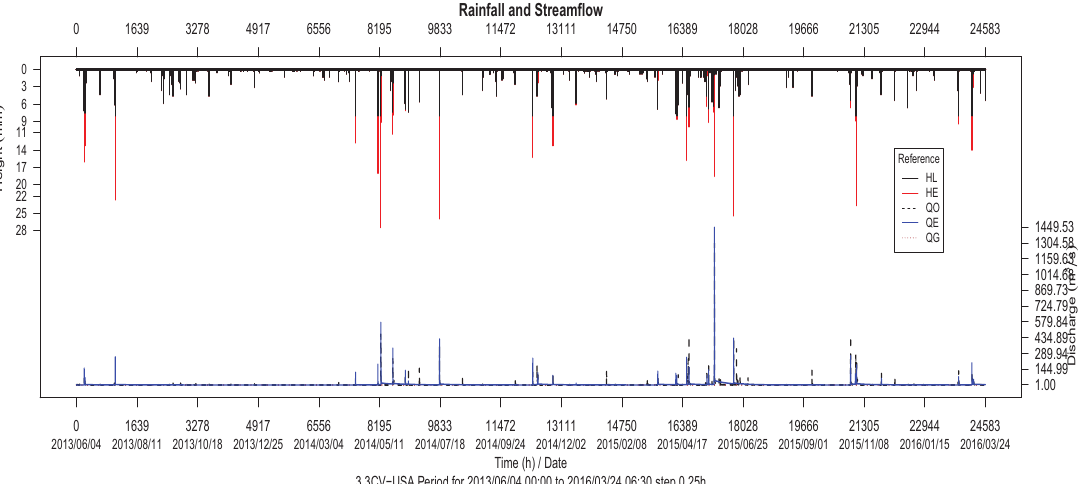
Figure 13. Hyetograph and Hydrograph from validation data series 3.3CV of San Antonio river, at Loop 410, USA.